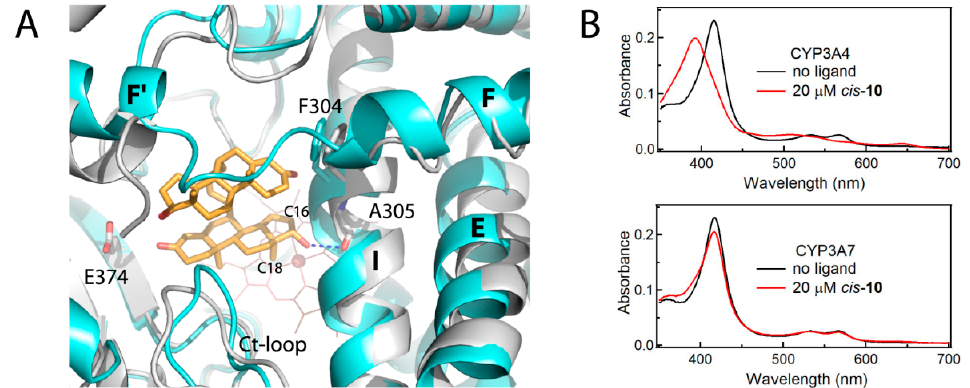
Figure 10. ( A ) Displacement of the I-helix in CYP3A4 bound to the high affinity type I ligand, cis - 10 (7lxl structure; in gray). This conformational change would be impossible in CYP3A7 (in cyan) due to tighter packing of the I-E-D-helical core. The cis - 10 ligand is shown in orange sticks; the blue dotted line is an H-bond linking the sterol hydroxyl group to the A305 carbonyl. Changes in the CYP3A4 helical core triggered by other ligands are demonstrated in Supplementary Figure S4. ( B ) Complete and partial (~20%) high-spin shift induced by cis - 10 in CYP3A4 and CYP3A7, respectively. Absorbance spectra of 2 μ M proteins were measured in 0.1 mM potassium phosphate pH 7.4, supplemented with 20% glycerol and 1 mM dithiothreitol.